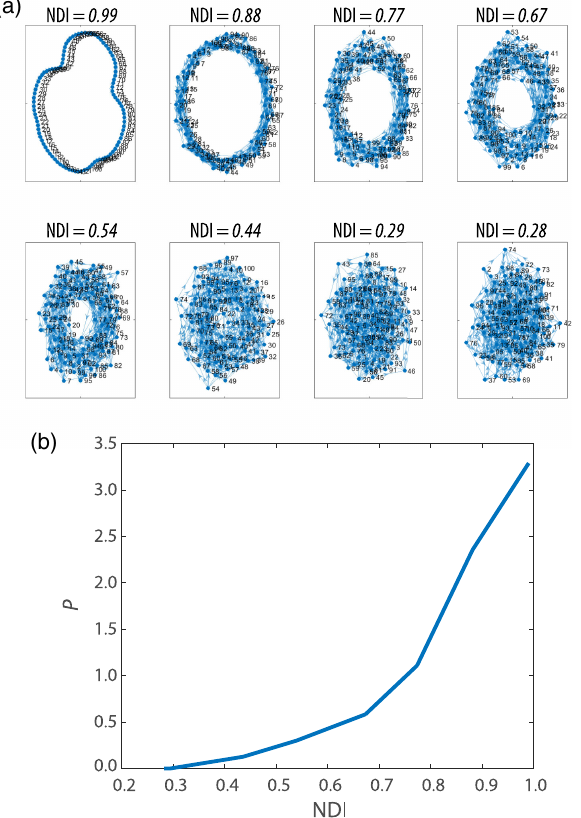
FIG. 3. The Mekong Delta multiplex [44]. The top panel shows the extracted channel network of the Mekong Delta at 50-m resolution. The bottom panel shows the behavior of the smallest (in terms of its real part) nonzero eigenvalue Re ð Λ 2 Þ of the supra- Laplacian L out corresponding to the Mekong Delta multiplex as a function of D X . For intermediate coupling rates, D X ∼ 1 , maxi- mum Re ð Λ 2 Þ is